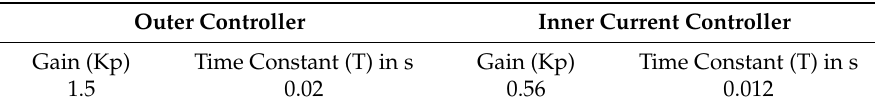
Table 1. Tuning of PI controller for voltage-frequency (VF) inverter